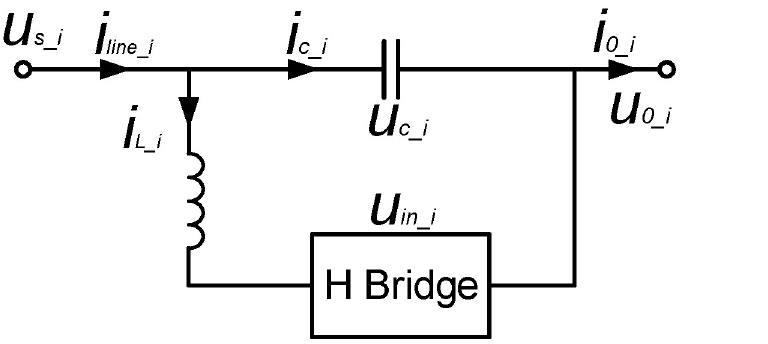
Fig 2. Equivalent circuit model of HB-MMC.